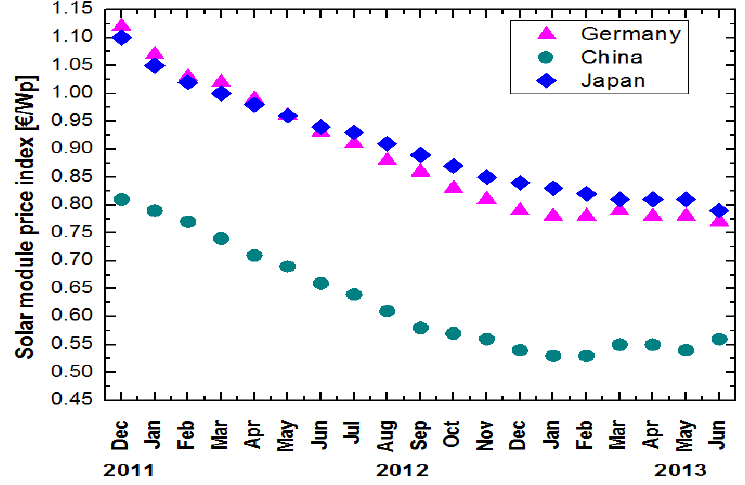
Figure 2. Development in the photovoltaic module prices in China, Germany and